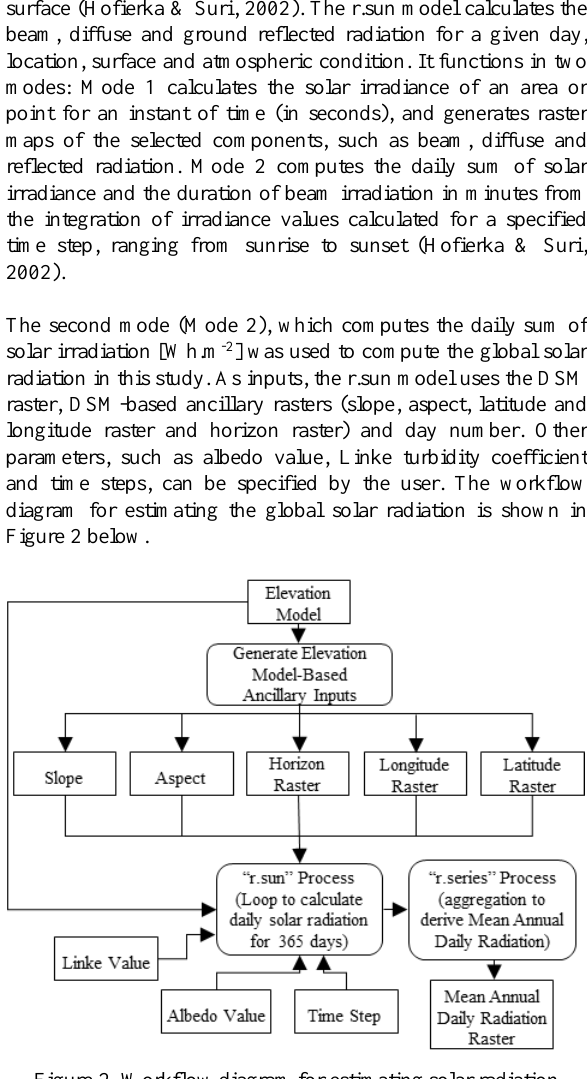
Figure 2. Workflow diagram for estimating solar